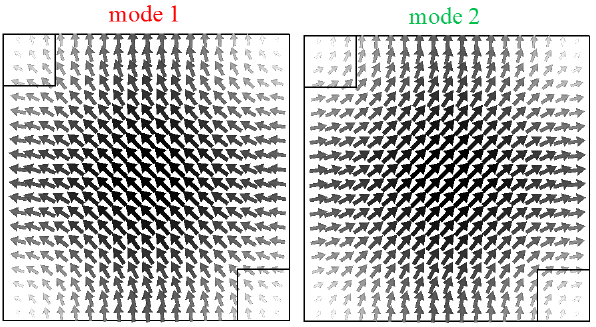
FIGURE 2.Electric field vectors of two orthogonal fundamental TE modes at ports of a square guide (sections of irises are highlighted for modes